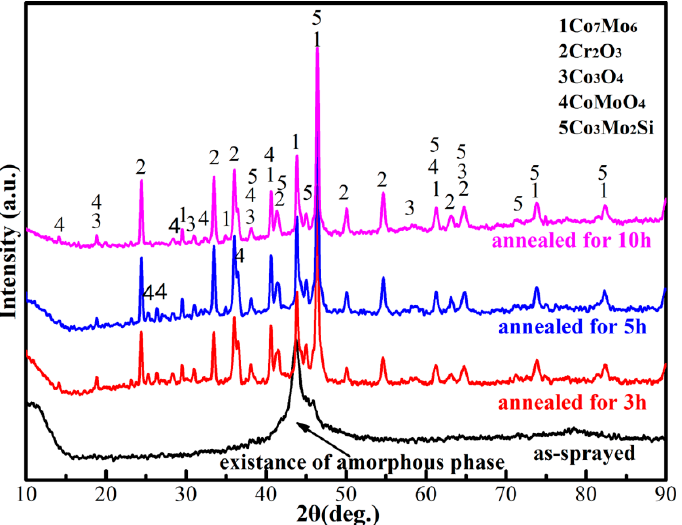
Figure 2. X-ray diffraction patterns of as-sprayed and annealed CoMoCrSi